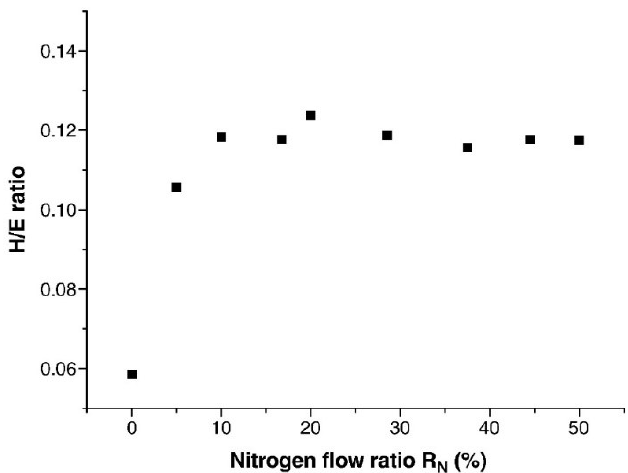
Figure 6. H/E ratio of AlCrNbSiTiV nitride films deposited at different nitrogen flow ratios. Repro- duced with permission from [38]. Copyright 2009, Elsevier.